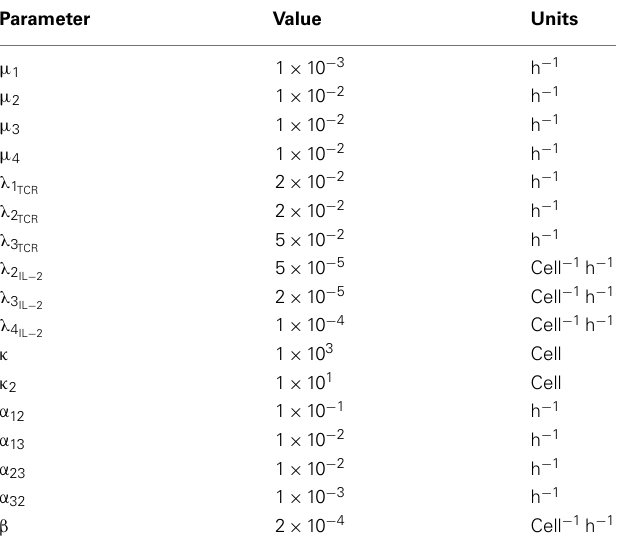
Table 1 | Parameter values and dimensions for a quorum-sensing model of CD4T cell